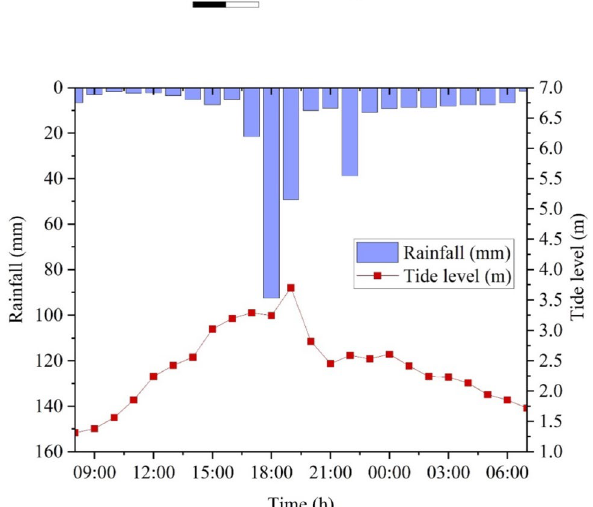
Fig. 5 Rainfall and tide level on Haidian Island at the time of